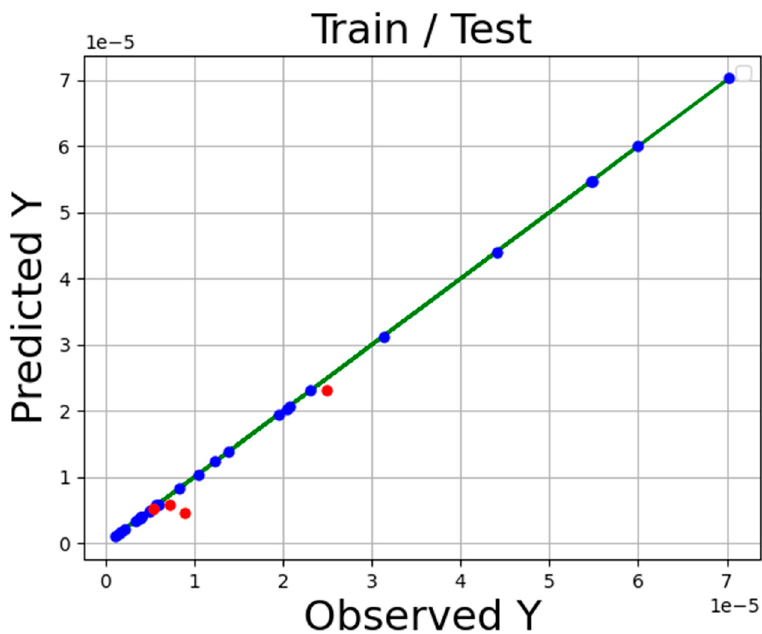
Figure 1. Fitting chart for ADA ‐ KNN.